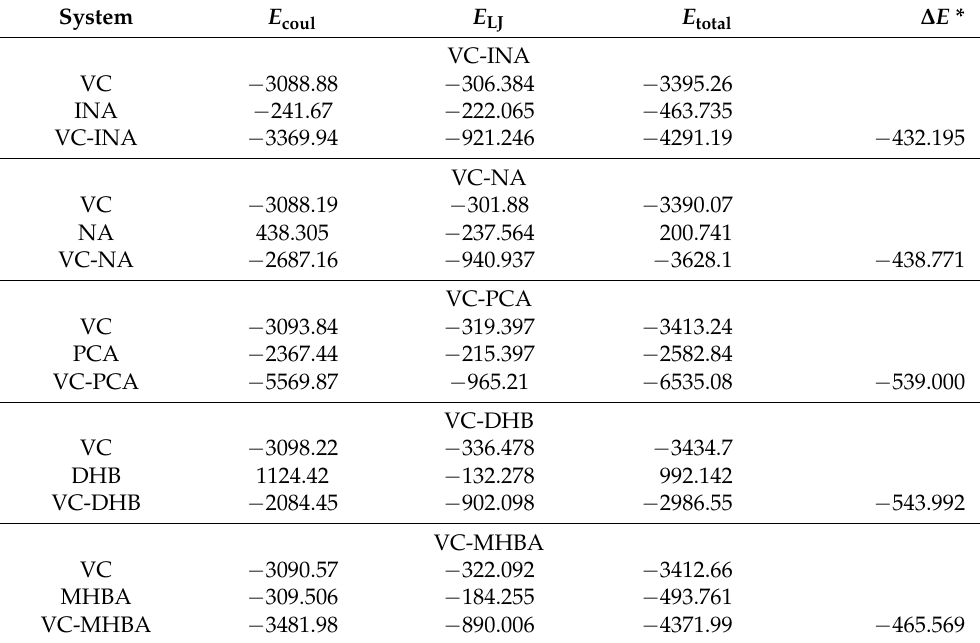
Table 2. Interaction energies (kJ · mol − 1 ) of VC/co-crystals without water.